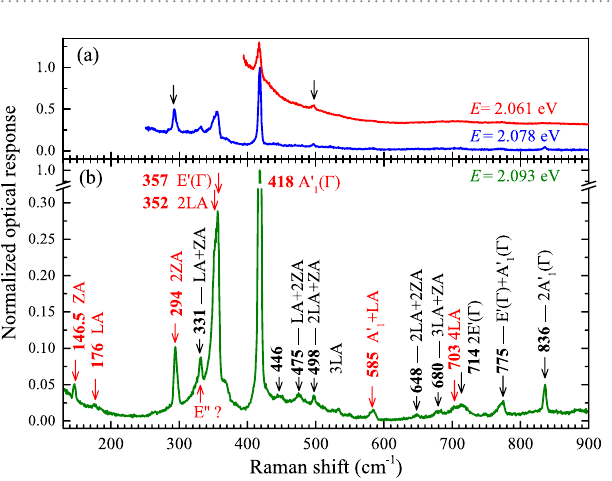
Figure 3. Low-temperature ( T = 5 K) Raman scattering excitation spectra of monolayer WS 2 detected at ( a ) E = 2.061 eV and E = 2.078 eV; ( b ) E = 2.093 eV. The horizontal scale represents the Stokes shift between the excitation energy and the detection energy. The spectra are normalized to the most intense peaks. The assigned peaks correspond to phonons from the M point of the Brillouin zone unless otherwise stated. Features reported in earlier study are marked with red